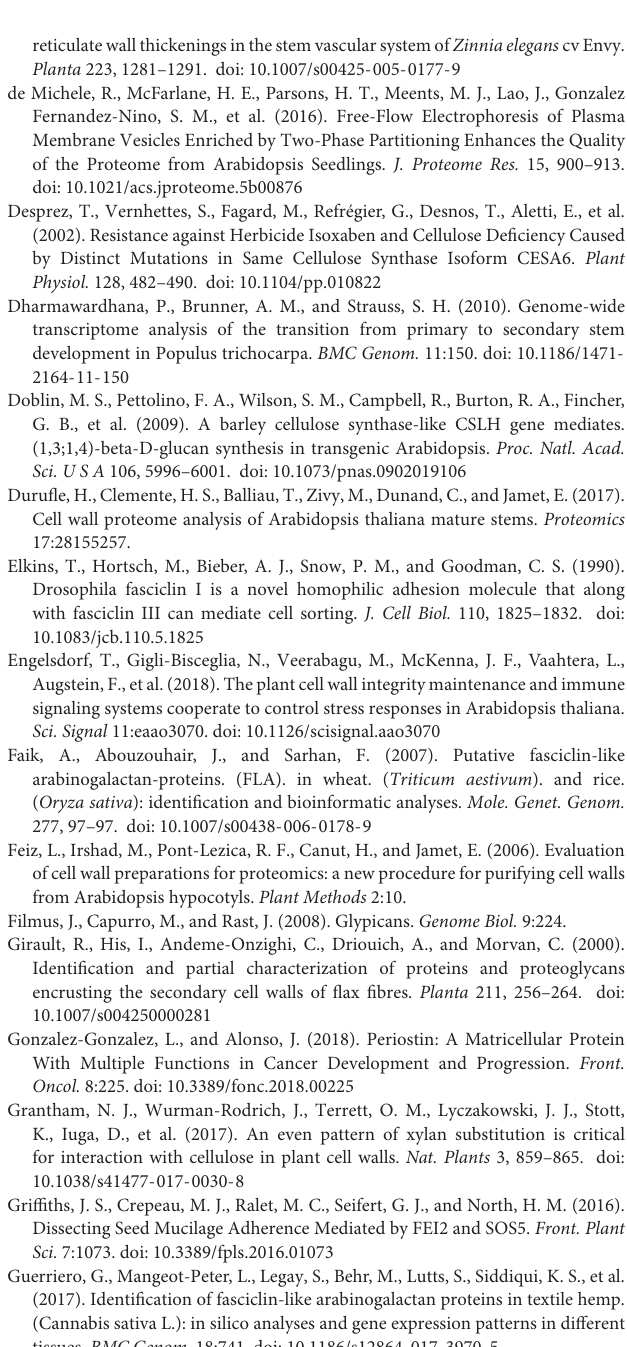
Supplementary Figure 5 | Phenotyping of WT and fla16 mutants at selected growth stages. Supplementary Figure 6 | Cellular morphology in transverse sections of WT and fla16 mature stems stained with toluidine blue and Mäule reagent. Supplementary Figure 7 | Transmission electron micrograph image of interfascicular fiber cells at the stem first internode of pFLA16 :FLA16-VH. Supplementary Figure 8 | Complementation of the fla16 mutant with pFLA16:FLA16 and pFLA16:FLA16-VH .